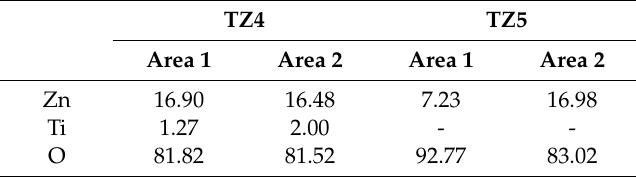
Figure 6. FE-SEM images and EDS spectra of ( a , b ) TZ4 and ( c , d ) TZ5 by EDS point analysis. Table 3. Chemical composition in atomic percent of TZ4 and TZ5 by EDS point analysis.